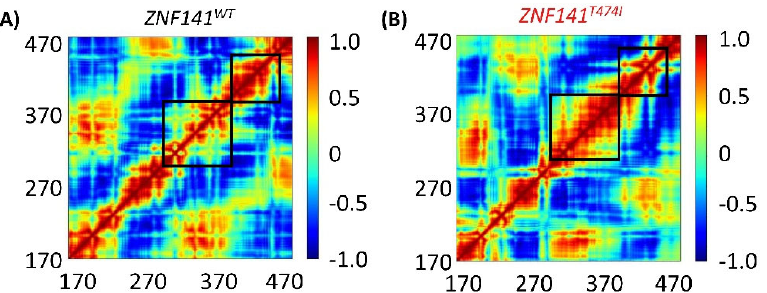
Figure 6. The dynamic cross-correlation map (DCCM) depicts the collective atom fluctuations for both the systems together with the associated movements of protein residues. The red hue symbolizes positive correlation, the white color represents local displacement, and the blue color represents negative correlation. ( A ) DCCM graph of ZNF141 WT shows significant positive and negative correlation at different positions while ( B ) shows the DCCM of ZNF141 T4741 . The correlation map of R406 ‐ K426 and V447 ‐ F460 residues is completely different for both systems.